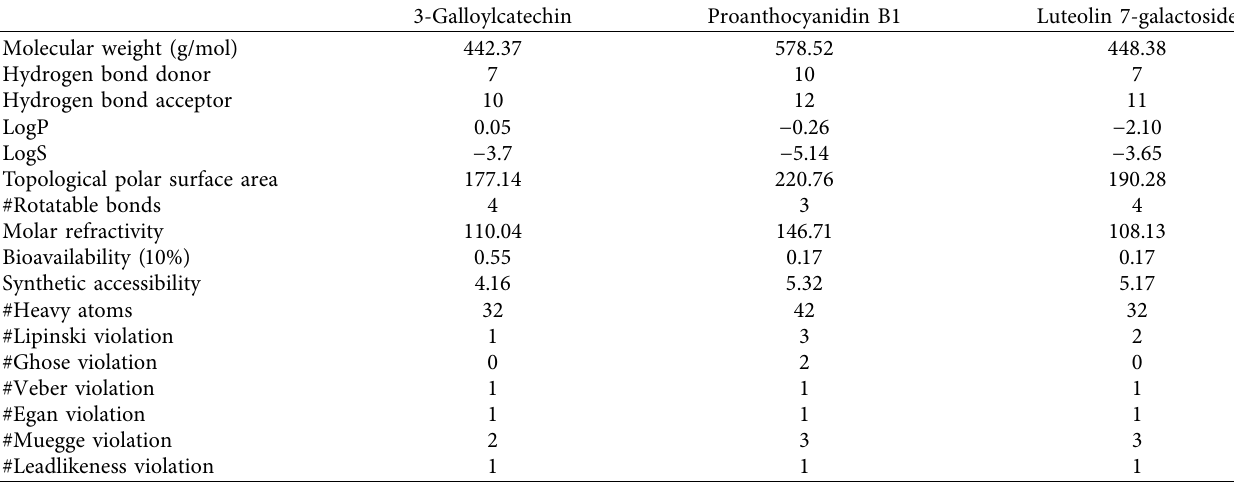
Table 3: Predicted physicochemical and druglikeness properties of potential SARS-CoV-2 multitarget hit ligands.